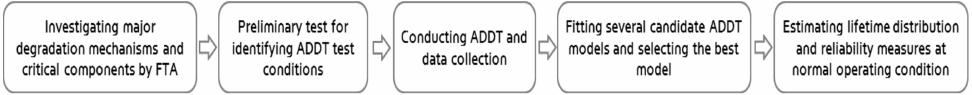
Figure 3. A flow diagram for the accelerated destructive degradation test (ADDT) and data analysis